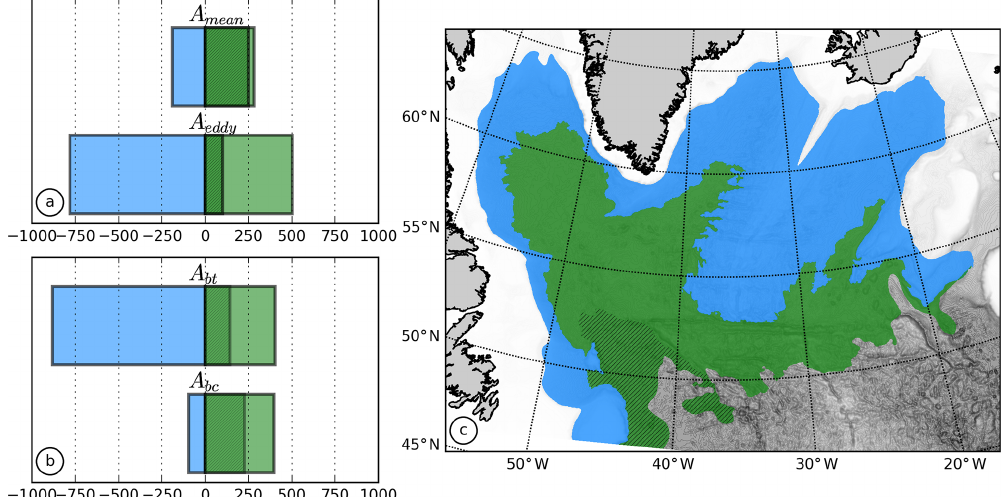
Figure 13. Integration of the nonlinear term in the slope ( c , blue) and interior area ( c , green) for the mean eddy decomposition (a) and the barotropic–baroclinic decomposition (b) . The hatches are the contribution from the northwestern